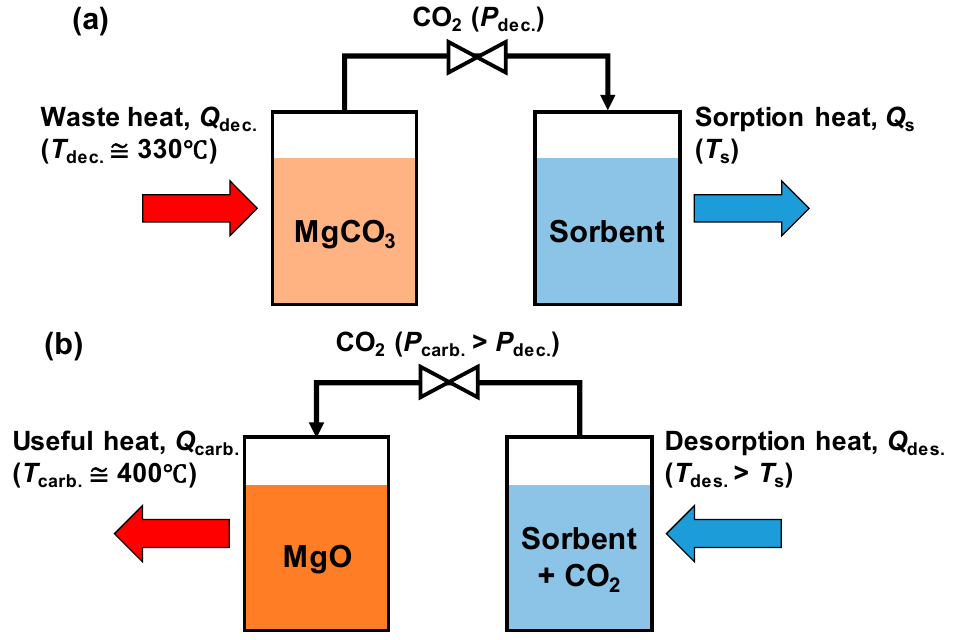
Figure1. PrincipleofMgO / CO 2 / sorbentTCESsystem. ( a )HeatstorageprocessbyMgCO 3 decarbonation. Figure 1. Principle of MgO/CO 2 /sorbent TCES system. ( a ) Heat storage process by MgCO 3 ( b ) Heat output process by MgO decarbonation. ( b ) Heat output process by MgO carbonation.